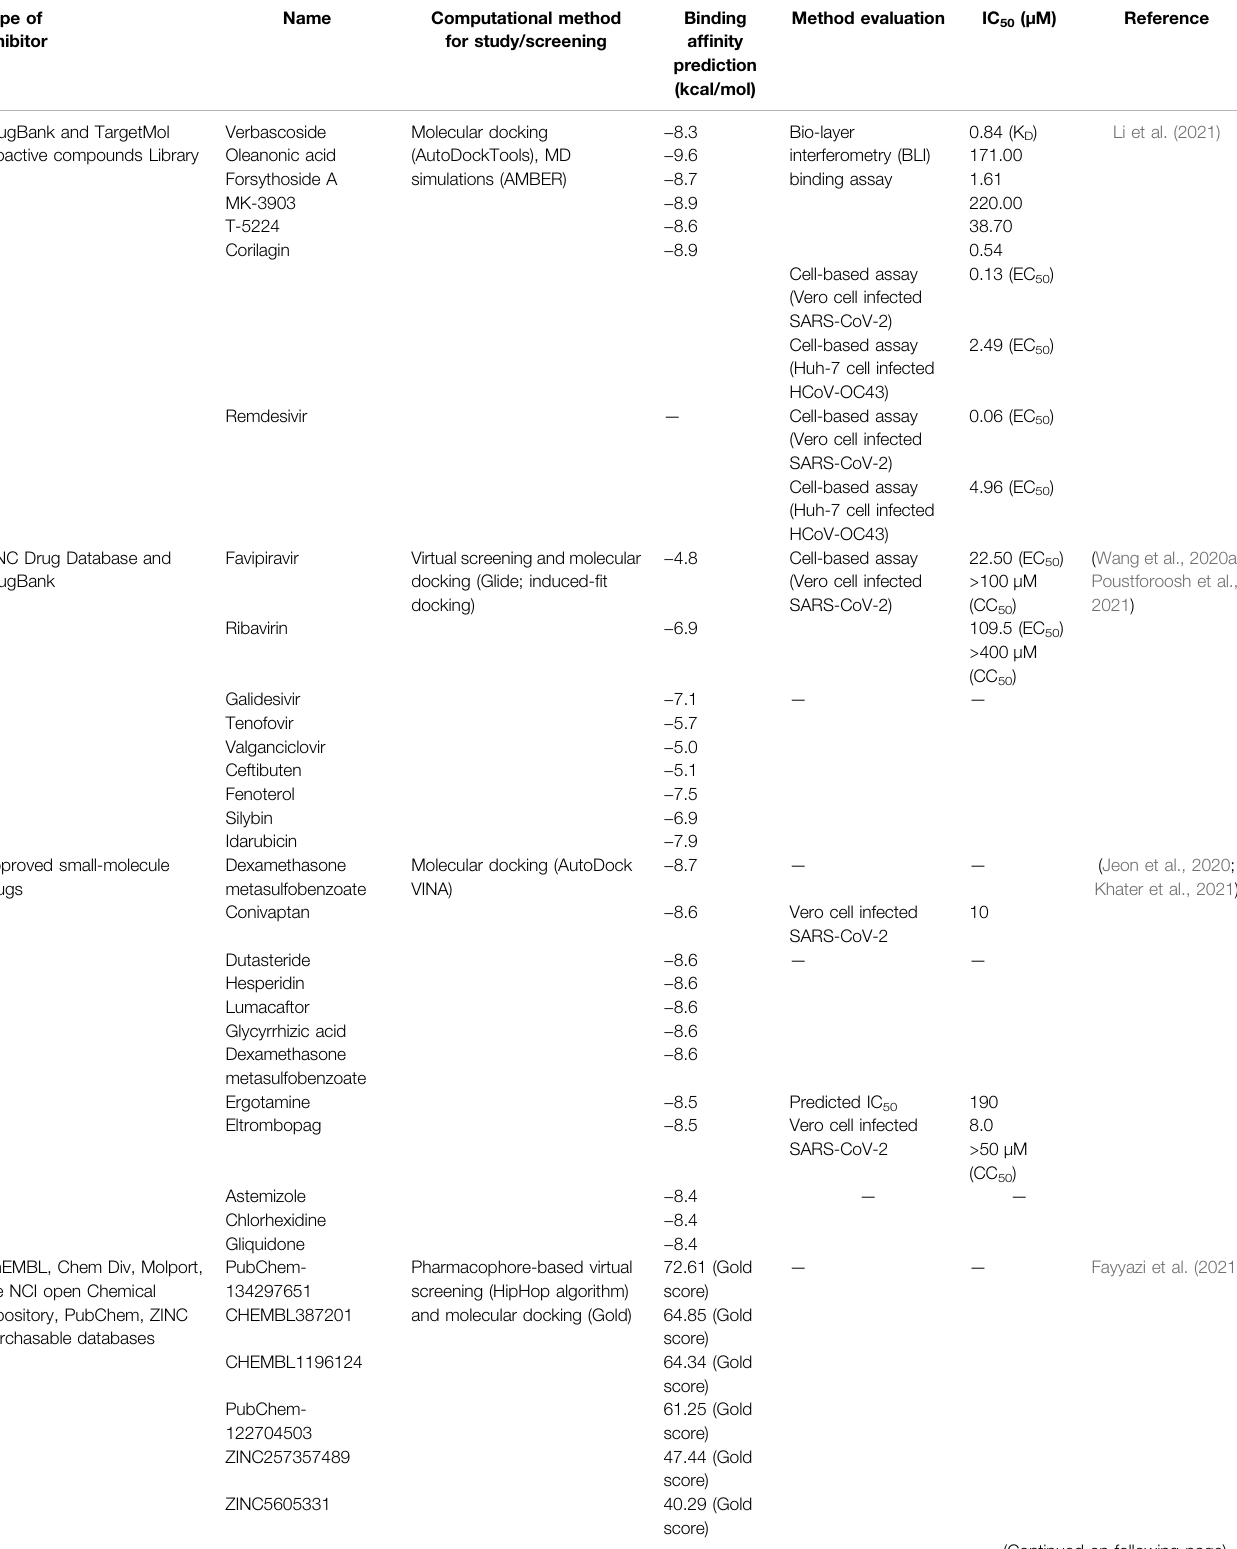
TABLE 7 | Inhibitors against SARS-CoV-2 RdRp derived from in silico screening. Type of